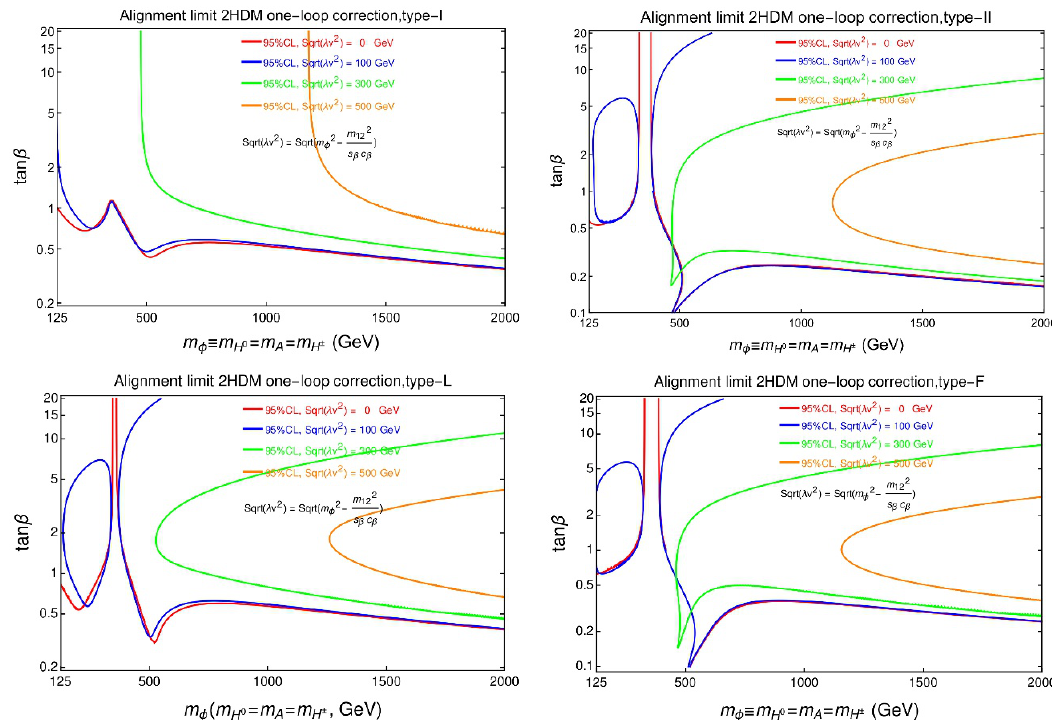
Figure 6 . 95% C.L. constraints on tan (cid:12) vs. m (cid:30) plane based on CEPC Higgs precision measure- ments. The orange, green, blue and red (from right to the left at the large m (cid:30) region) are for p q (cid:21)v 2 (cid:17) m 2 (cid:0) m 2 12 =500, 300, 100, 0 GeV, respectively. Regions to the right of the curves (cid:30) s (cid:12) c (cid:12)